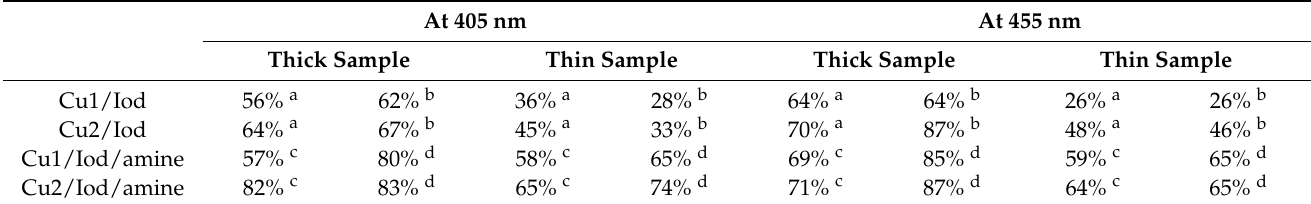
Table 2. Final reactive functions conversion (FC) for TA monomer using two or three-component PISs upon exposure at different wavelengths (LED at 405 and 455 nm).